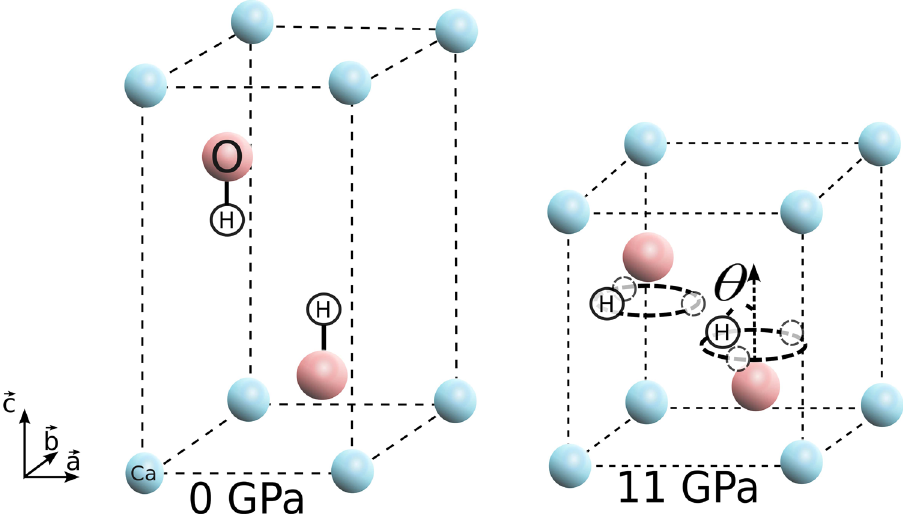
Figure 1. Scheme of the proton disorder in layered calcium hydroxides at low and high pressures. Ca, O and H atoms are indicated in blue, red and white, respectively. At a higher pressure the hydroxyl groups tilt by an angle θ with respect to the c axis, while H atoms can occupy other possible sites as indicated by black dotted